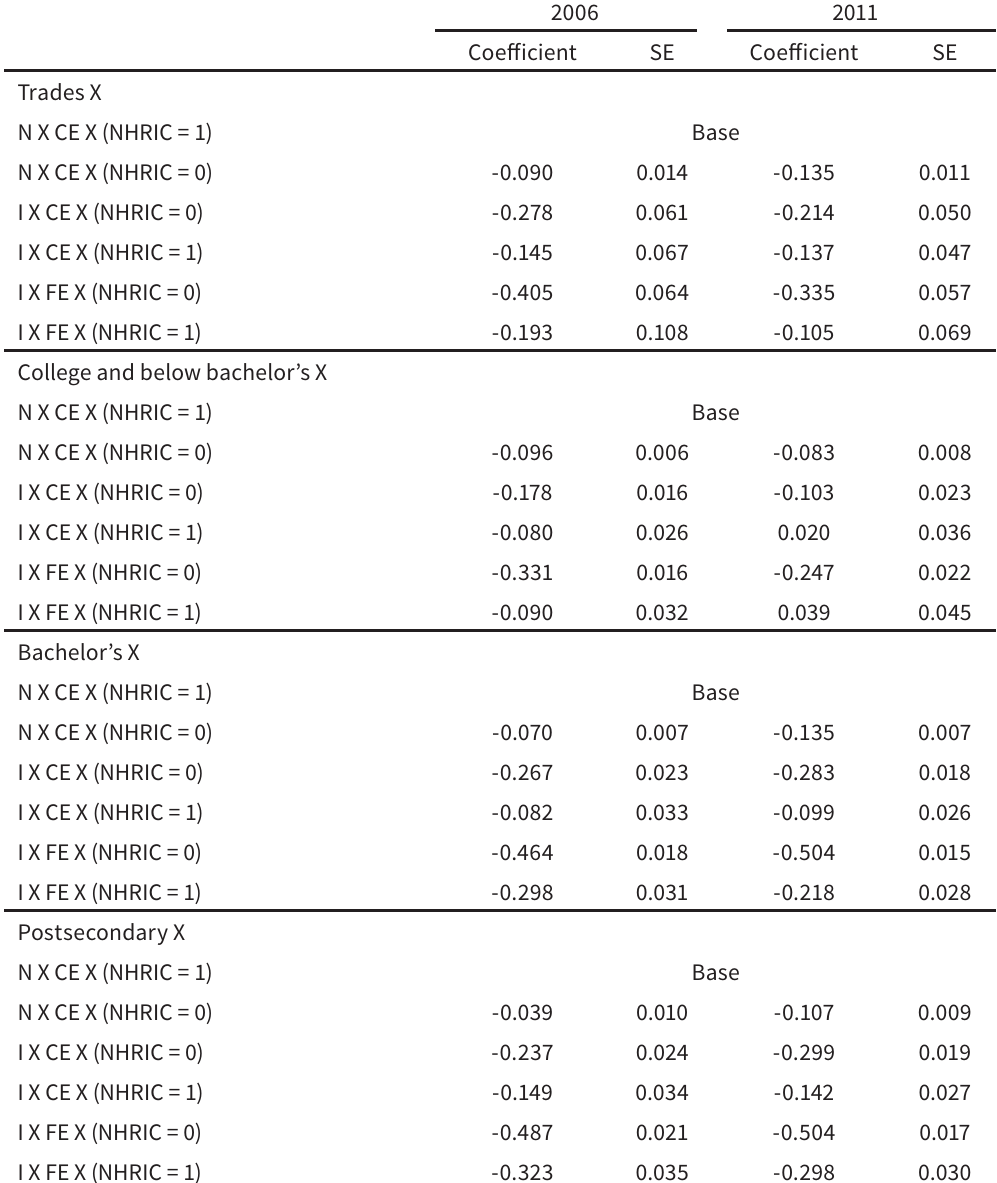
SWF estimates of the wage gap across workers by nativity, NHRIC, education degrees, and location of study with heteroskedastic inefficiency – 2006 and